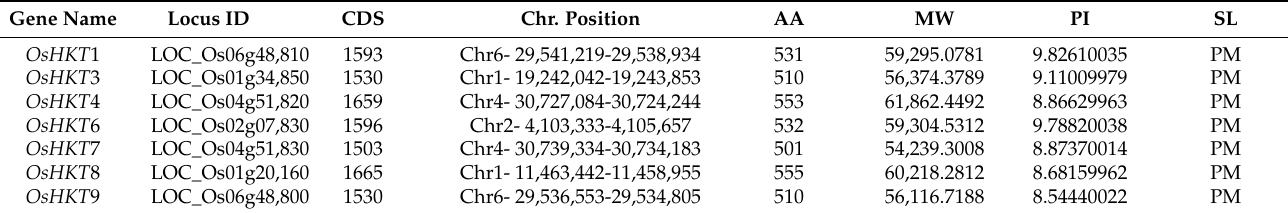
Table 1. Genomic information of OsHKT gene family in